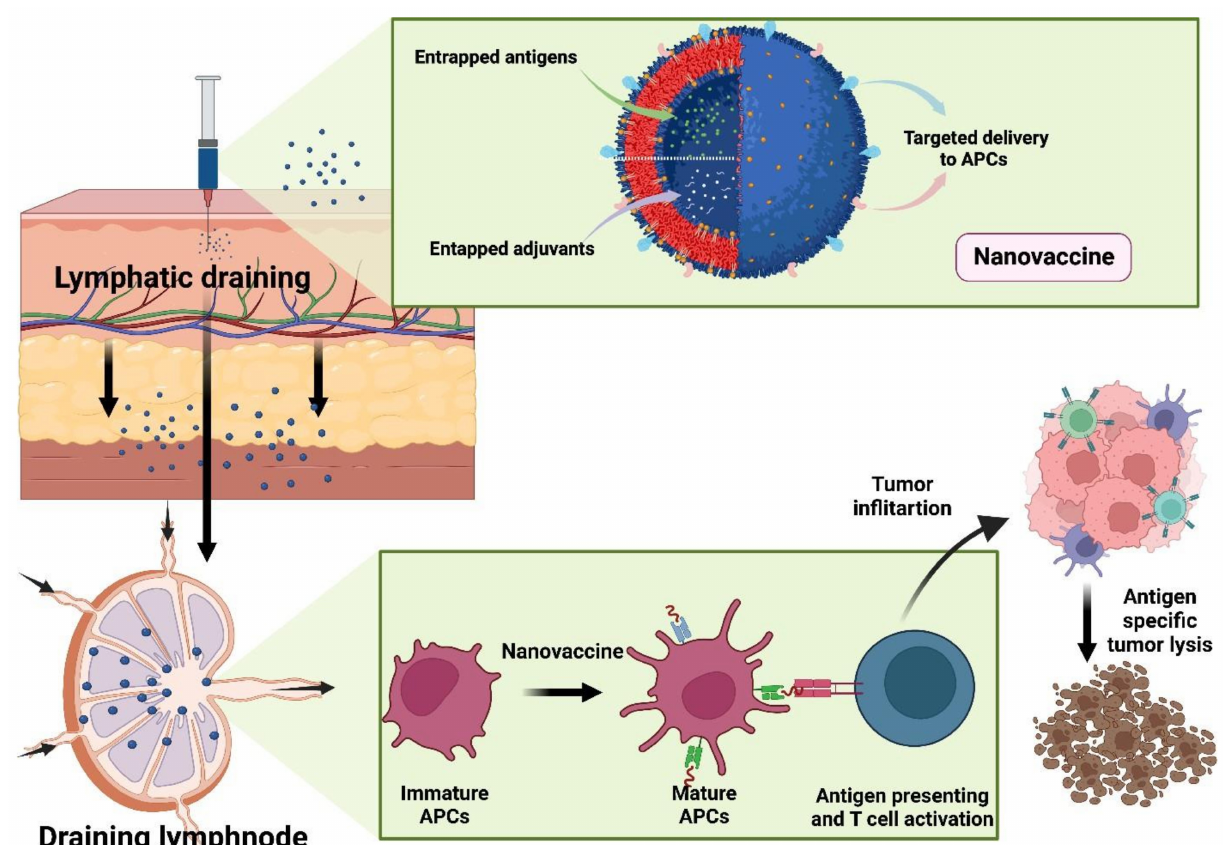
Figure 3. Nano vaccine and cancer